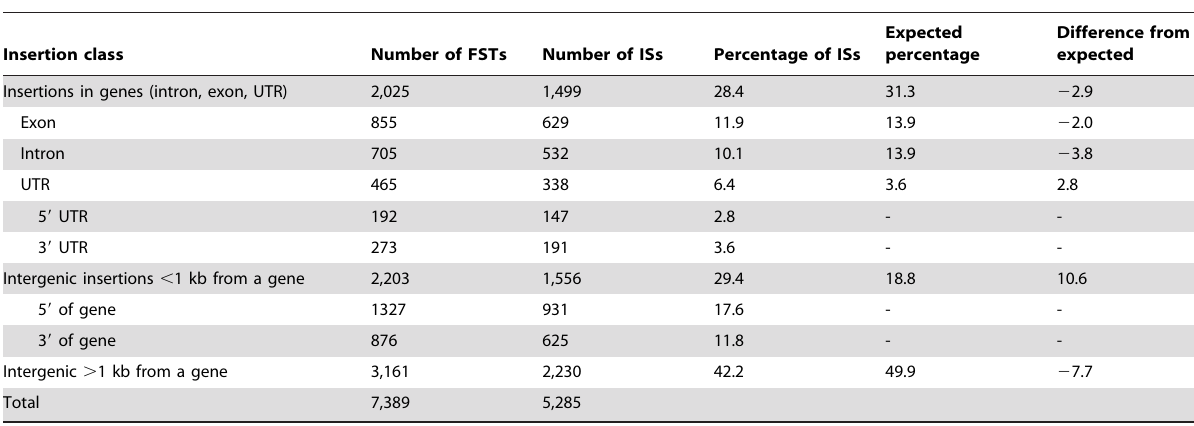
Table 8. Distribution of FSTs and ISs between genic and intergenic regions.